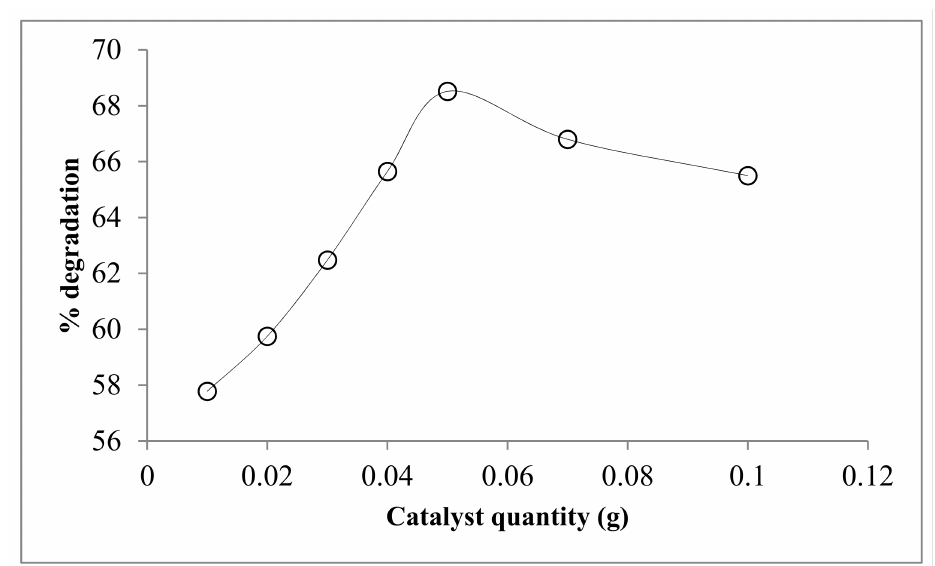
Figure 9. Catalyst loading effect on % degradation of selected dye over Pd/ZrO 2 .